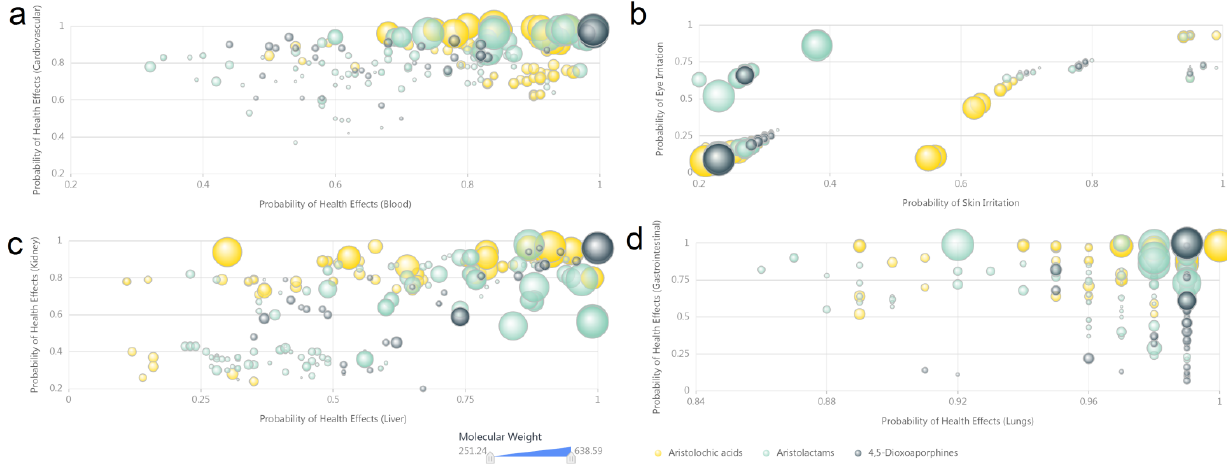
Figure 7. The scatter plot of computer-predicted health effects of aristolochic acid analogues. ( a ) Probability of health effects (blood and cardiovascular). ( b ) Probability of irritation (skin and eye). ( c ) Probability of health effects (liver and kidney). ( d ) Probability of health effects (lungs and gastrointestinal). High-resolution image file of this figure can be found in Supplementary Materials as Figure S5.